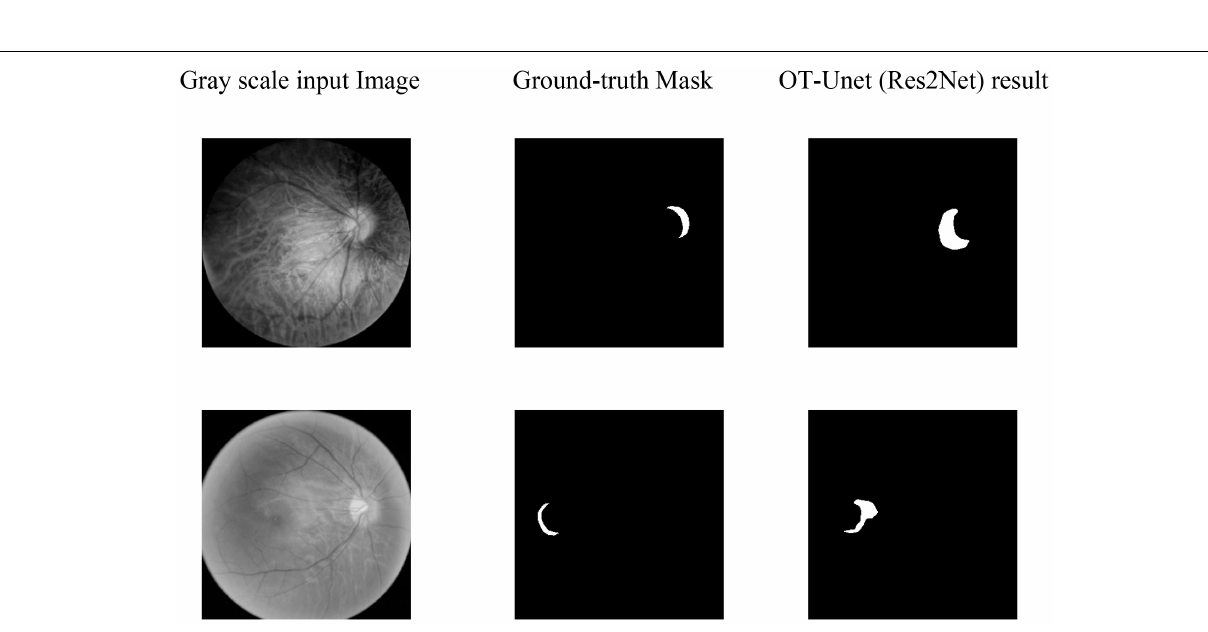
Frontiers in Neuroscience |